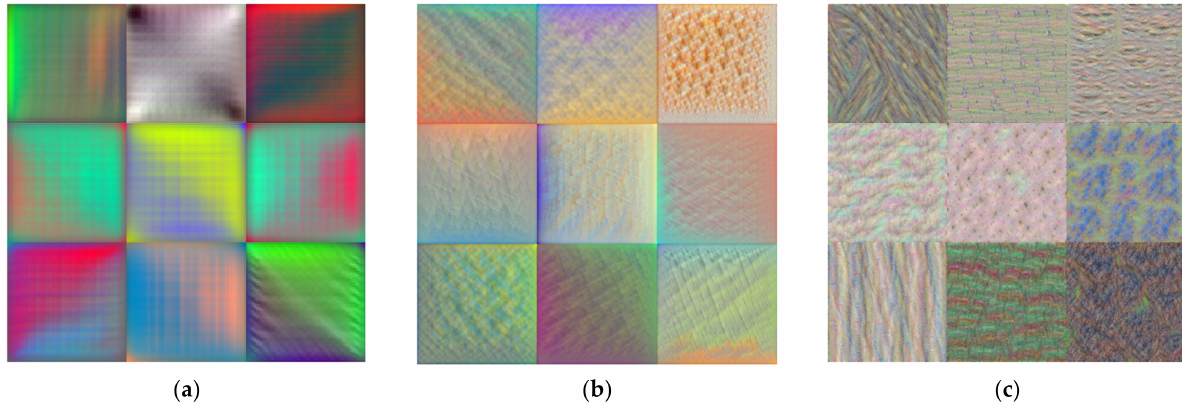
Figure 2. Examples of features extracted from AlexNet trained with ImageNet data: ( a ) low-level features; ( b ) medium-level features; ( c ) high-level